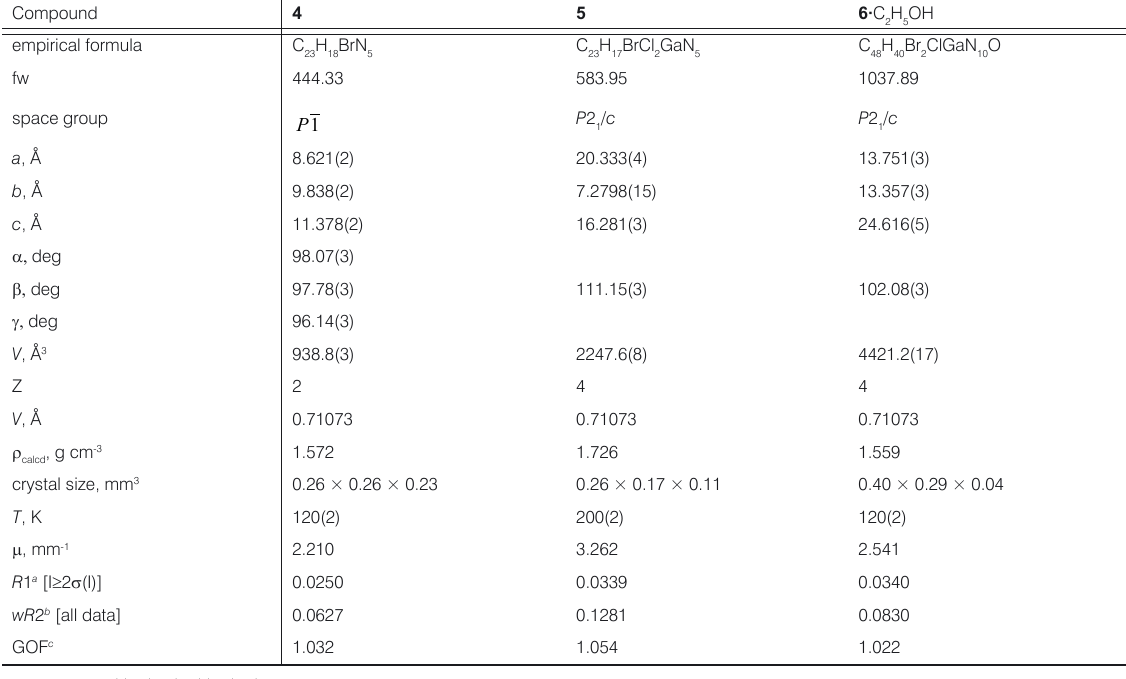
Table 1. Crystal data and details of data collection for 4 , 5 and 6